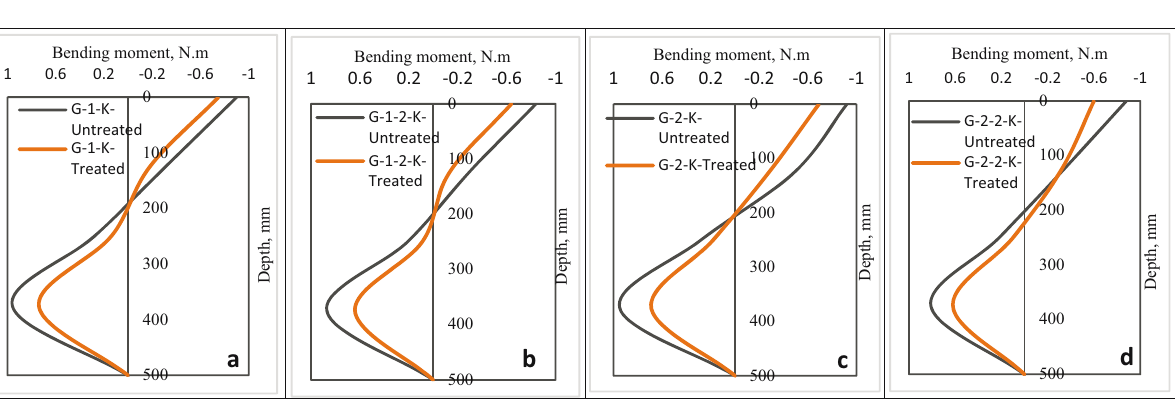
Figure 8: Bending moment of the pile group in treated and untreated soil with nano - SiO 2 – P1 at ( a ) 50% axial load, ( b ) 50% axial load and 100% lateral load, ( c ) 100% axial load, and ( d ) 100% axial load and 100% lateral